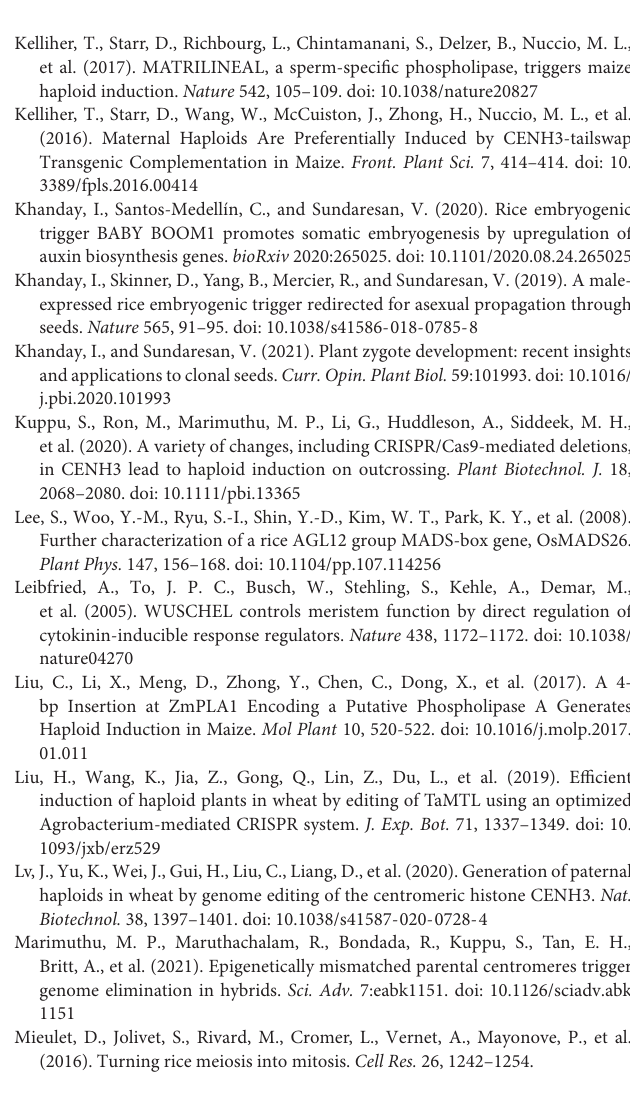
Supplementary Figure 1 | Annotated GS- PsASGR-BBML:GR insert sequence. Supplementary Figure 2 | DEX treatment and DIC screening for parthenogenesis. Supplementary Table 1 | Individual plant data generated for second DEX